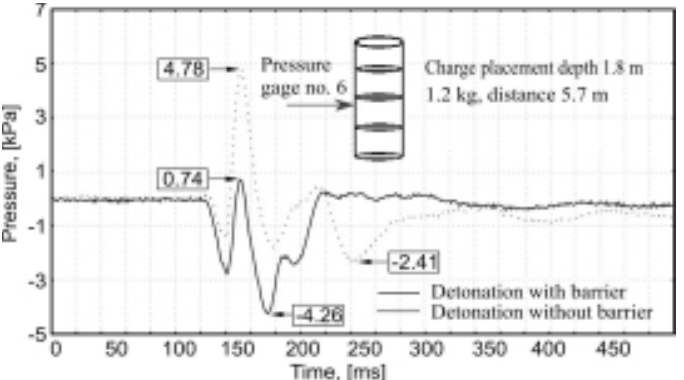
Fig. 18. Time histories of pressures p h acting on a structure rear, measured by gage No. 6 from a detonation at 5.7 m from the silo.